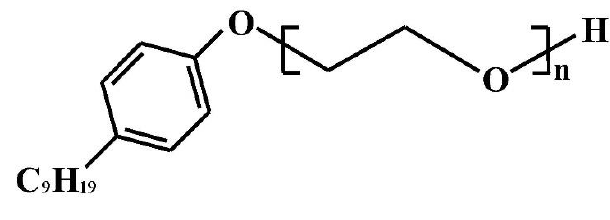
Figure 4. Chemical structure of NPnEO.